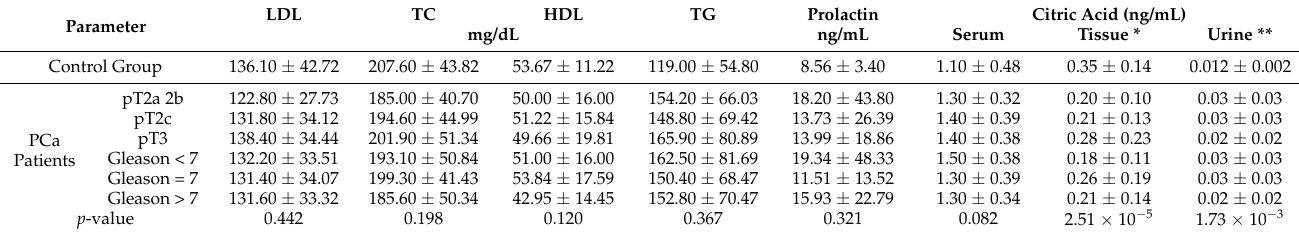
Table 2. The average concentration of citric acid and biochemical blood parameters in samples, arranged regarding evaluated subgroups. The table shows non-adjusted p -values referring to a com- parison between the concentration of parameters in the control and positive groups. * = concentration in the extract, normalized by weight; ** = concentration normalized to creatinine; SD = standard deviation; LDL = low density lipoprotein; TC = total cholesterol; HDL = high density lipoprotein; and TG =